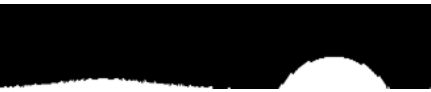
Figure 4. Normalized iris image.